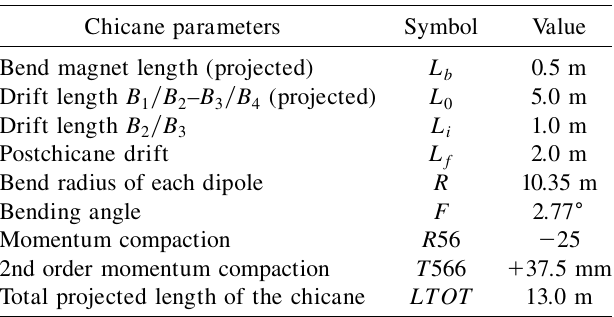
TABLE II. Compressor